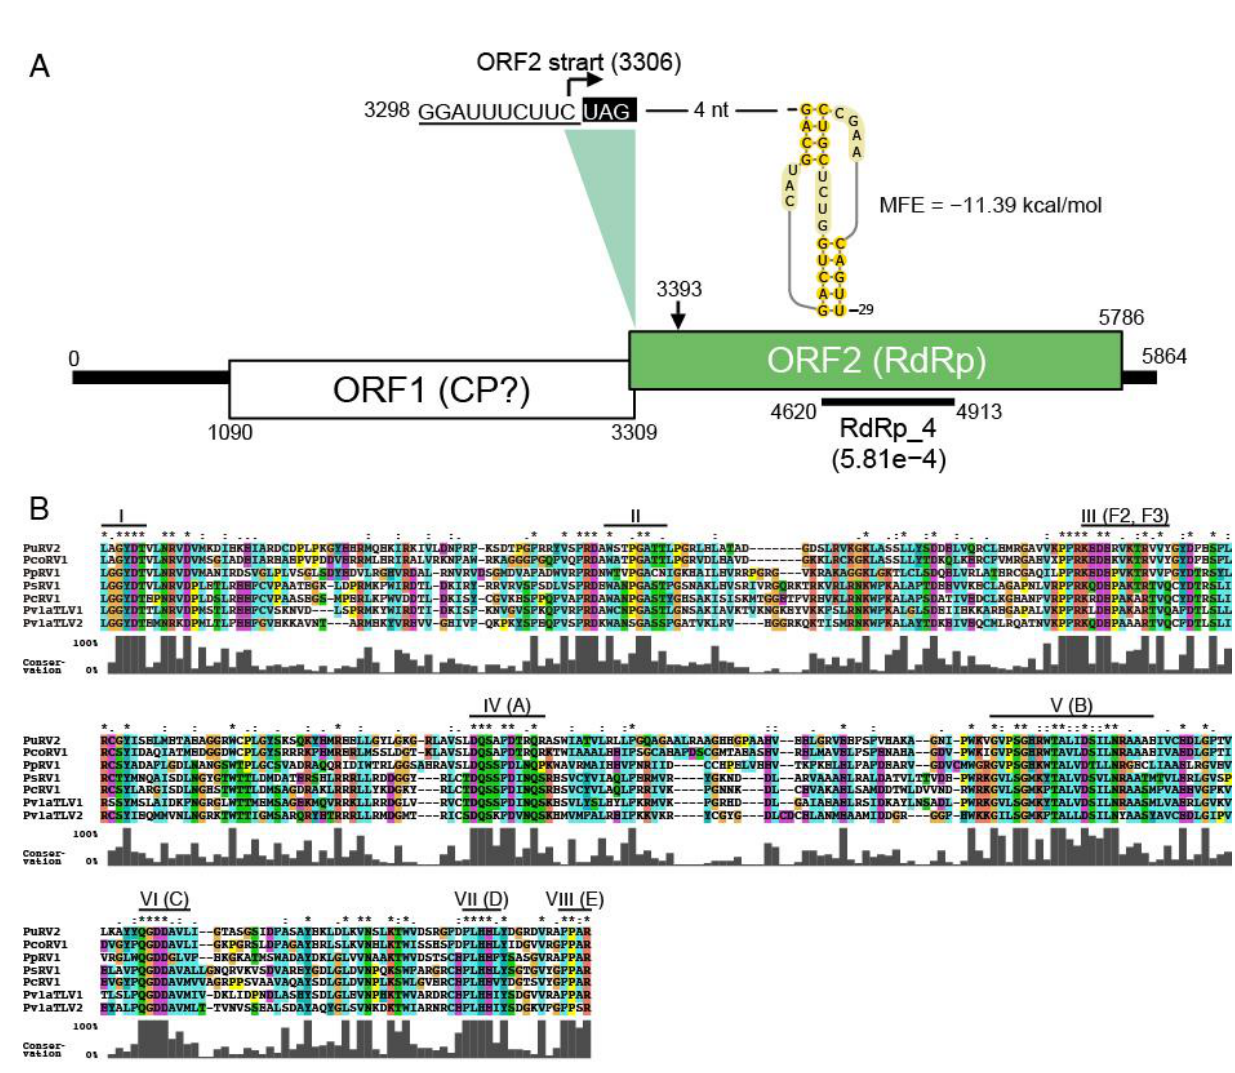
Figure 4. ( A ), The genome structure of PuRV2. The underlined sequence shows putative slippage sites and putative H-type pseudoknot to the right. Boxed regions show two open reading frames (ORFs). ( B ), Comparison of the amino acid sequence of the conserved RdRp region of PuRV2 and the other toti-like viruses from oomycetes. Amino acid sequences were aligned using MAFFT 7.423. I-IV(E) indicate the eight conserved motifs in the RdRps of dsRNA viruses [45–47]. Consensus symbols were assigned according to the BLOSUM62 scoring matrix: *, identical; nonidentical with score ≥1; nonidentical with score = 0.